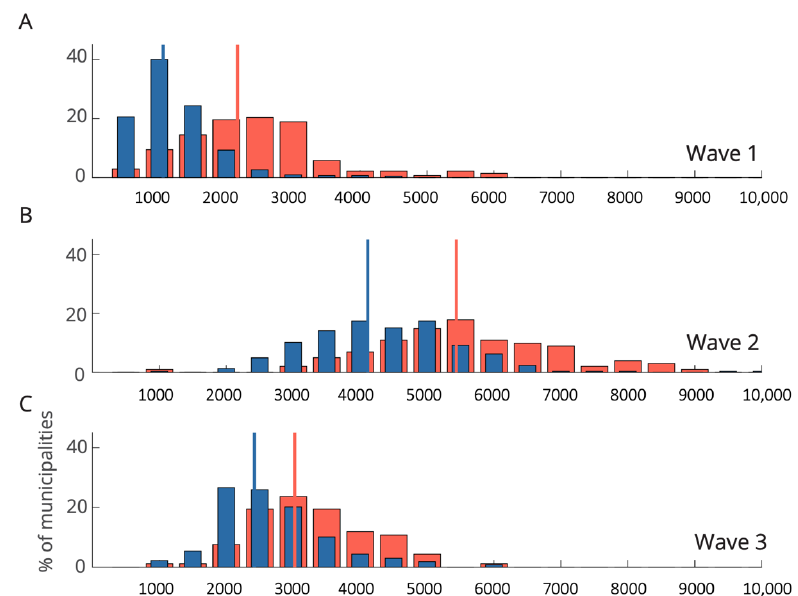
Figure A2. Distribution of COVID-19 Cumulative Infection Rates (per 100 k) by New Jersey munici- palities characterized as Relatively High Percentages of Latinx Residents (RHL-red) and Relatively Low Percentages of Latinx Residents (RLL-blue) during Wave 1 ( A ), Wave 2 ( B ), and Wave 3 ( C ). Notes: The vertical lines represent the mean infection rate in RHL (red) and RLL (blue) municipalities; so, the horizontal distance between the two vertical lines visualizes the disparity for each wave. In this figure, the red bars (RHL municipalities) are shifted consistently to the right of the blue bars (RLL municipalities) in all three waves, illustrating the consistency of the disparity across the full distribution of